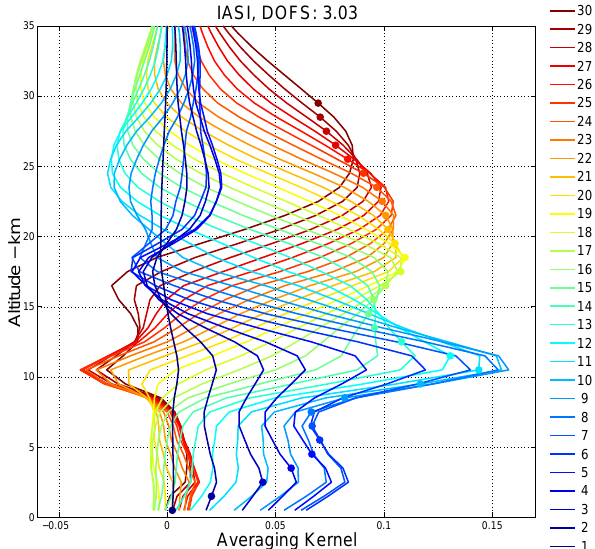
Fig. 2. Typical averaging kernel matrices and DOFs of ozone pro- file provided by IASI. The figure shows an example observed on 16 September 2010 over McMurdo. Each coloured line corresponds to the altitude indicated by the coloured dot.